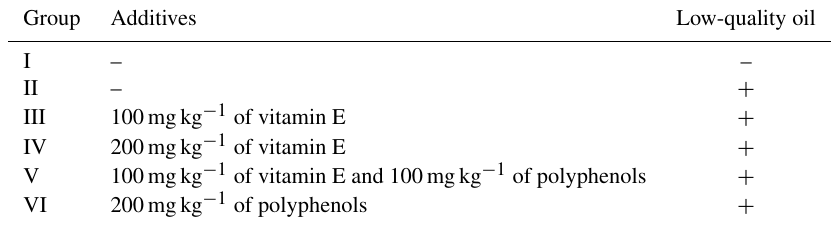
Table 1. Experimental design.